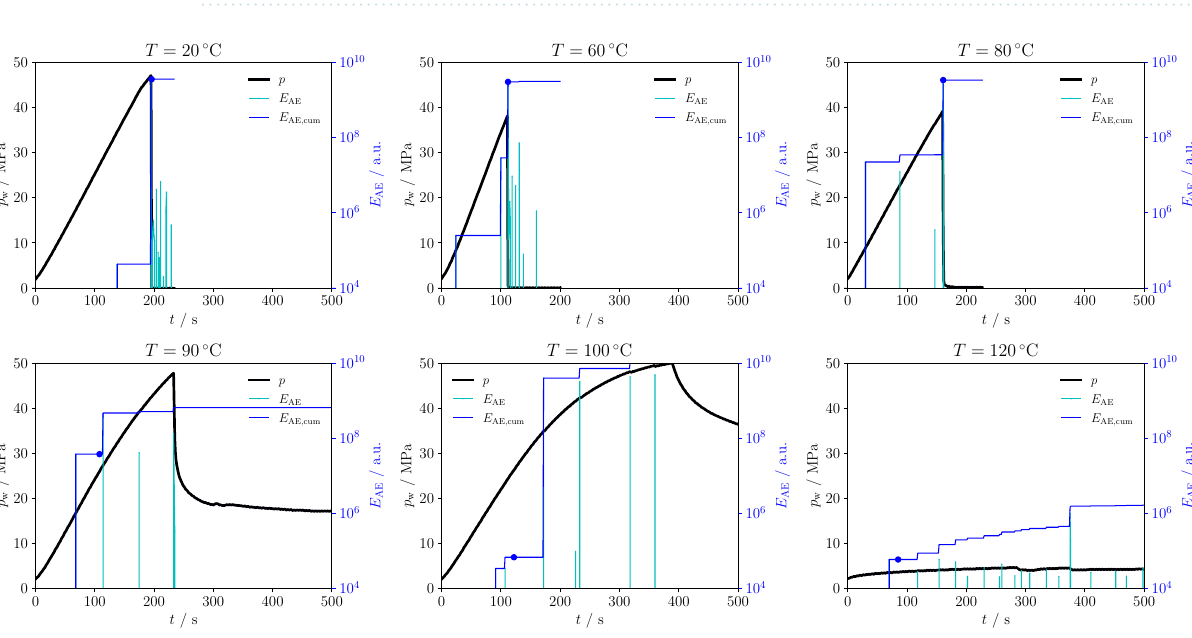
Figure 8. Fluid pressure, acoustic emissions’ energy and cumulative acoustic emissions’ energy recorded during the injection tests at different temperatures and following procedure P2. The pressure response shows a gradual increase in ductility with a slower post-peak drop, while a full transition to practically constant pressure is observed above the glass transition point. Cumulative AE energy at the fracture initiation (blue dot) also gradually decreases with increasing